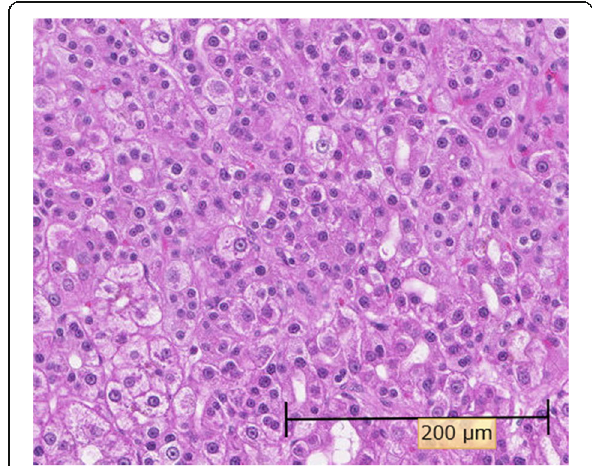
Fig. 4 Hematoxylin and eosin staining findings. Polygonal tumor cells with round nuclei and abundant eosinophilic cytoplasm formed thick trabeculae in the tumor. The differentiation